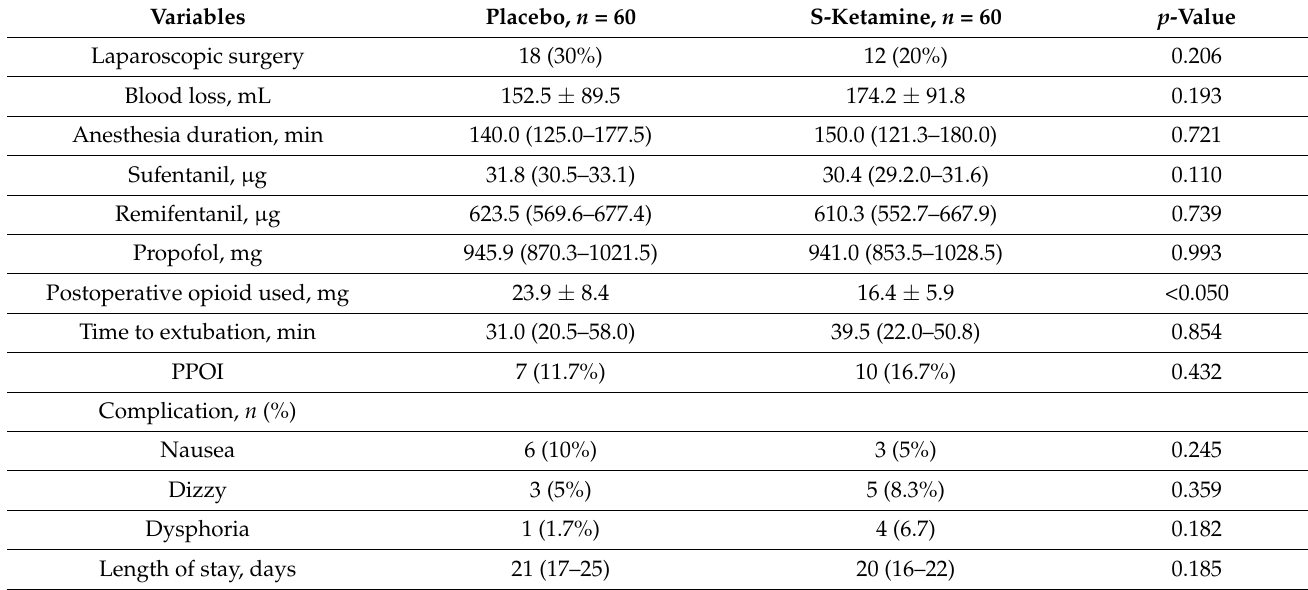
Table 3. Intraoperative and postoperative